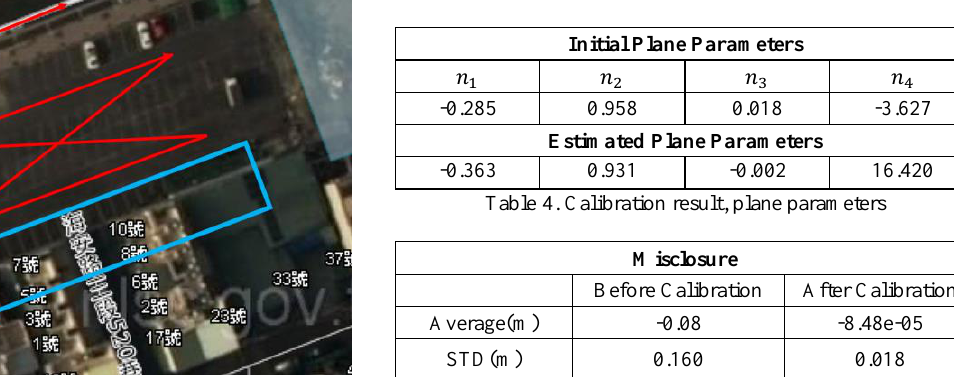
Table 5. Calibration result, misclosure